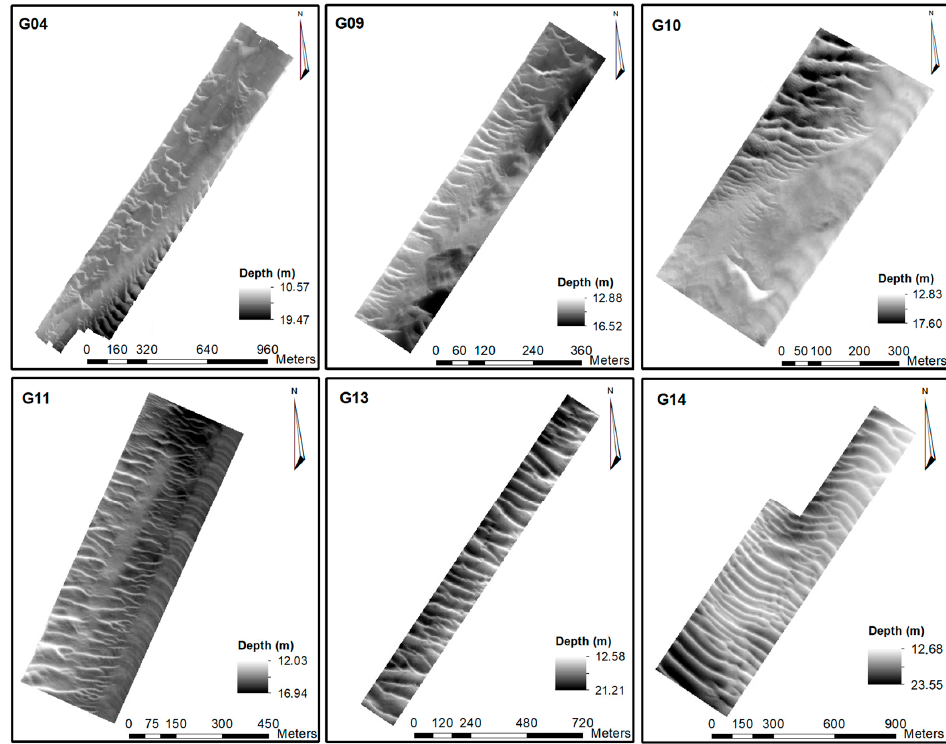
Figure 8. DBM of the sectors G04, G09, G10, G11, G13, and G14 of the Northern